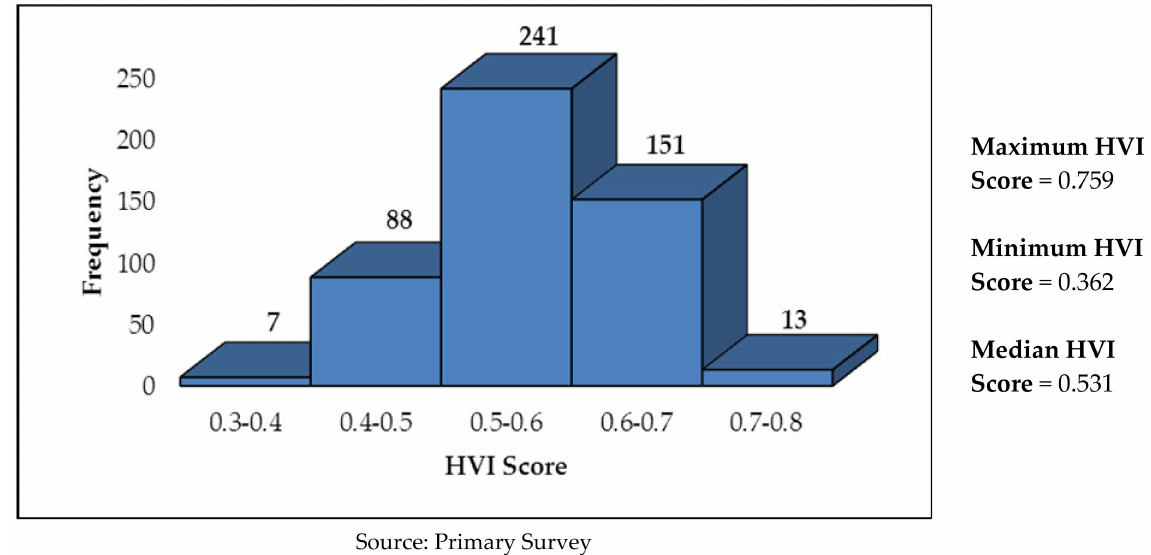
Figure 1. Pictorial Distribution of No. of Households by HVI Scores in